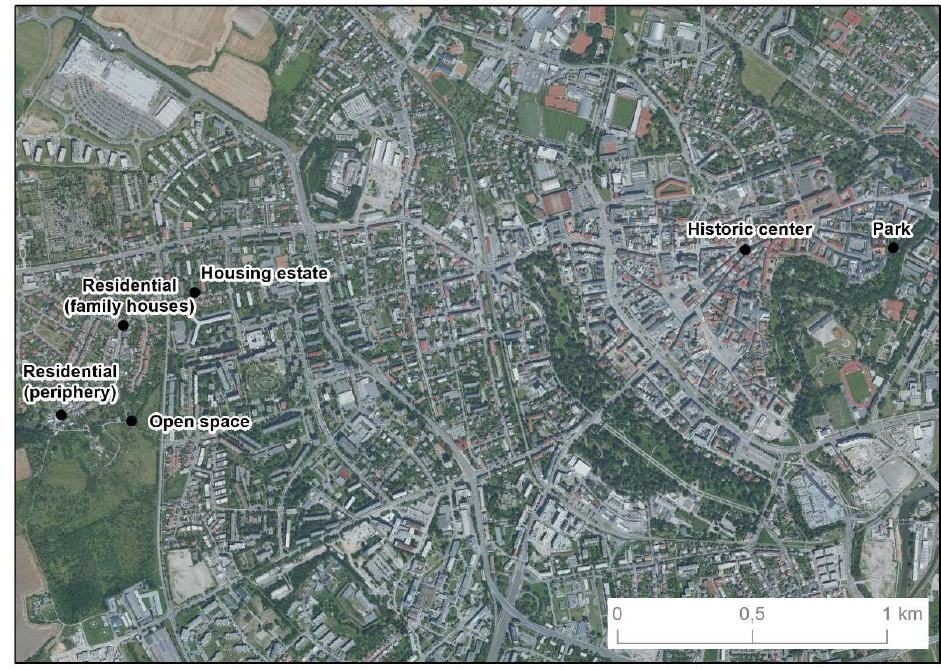
Figure 1. The location of the six selected geodetic points.